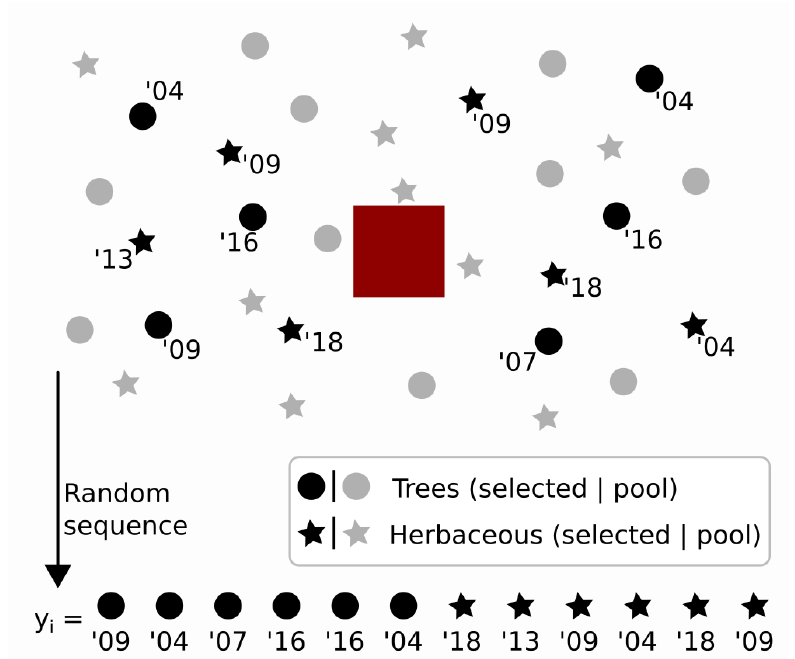
Figure 4. Example of temporal augmentation for a single time series. To generate random sequences, we start with a 150 km × 150 km grid cell (represented by the center red square). Then, we randomly select N samples within a predetermined radius around the grid cell. N is the length of the time series (12 years in this example, 20 in this study). To guide the augmentation, we define likely land cover transitions (Table 3). In this example, we are generating a 12-year pseudo time series based on data surrounding our center red grid of interest. To start, we would expect a pool of potential training samples surrounding our grid, where individual field samples would consist of a range of land covers and timeframes. This potential pool is illustrated by all the stars and circles (to simplify the illustration, we only have two land covers: tree and herbaceous). Since our target time series length is 12 years, we only need to randomly sample 12 points from the data pool. After a random sample from the data pool, the 12 samples selected are shown in black, and the remaining data in the grid pool are shown in gray. Next, we use the 12 samples to create the pseudo time series, which is shown by y = at the bottom of the graphic. The only condition driving the order is a land cover transition defined in Table 3. We are illustrating a tree-to-herbaceous land cover change and, therefore, first order all the sampled tree points followed by the remaining herbaceous samples. Note that the order of the years is not important here (and is random) because all 12 samples come from a different geolocation. This process is repeated to create a training dataset for the grid, sampling with replacement from the grid sample